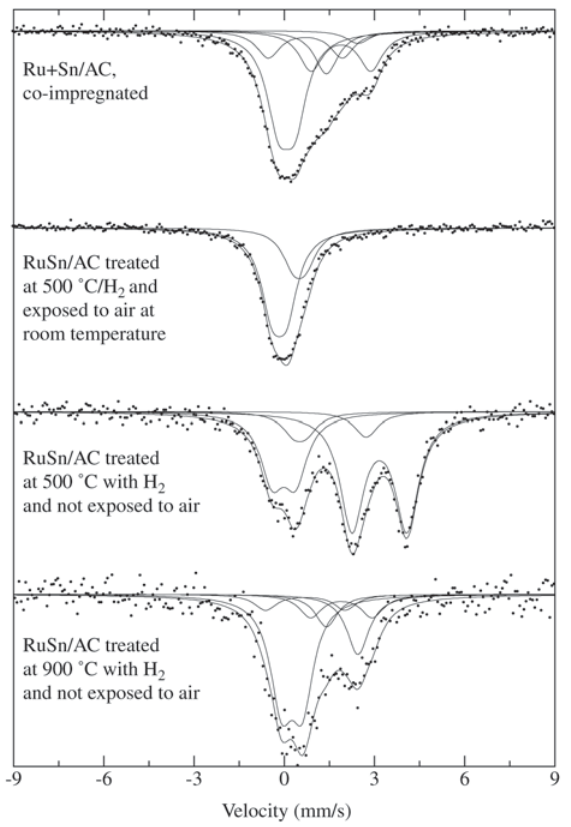
Figure 2. 119 Sn Mössbauer spectra obtained at 23 K for the carbon supported RuSn catalysts submitted to different